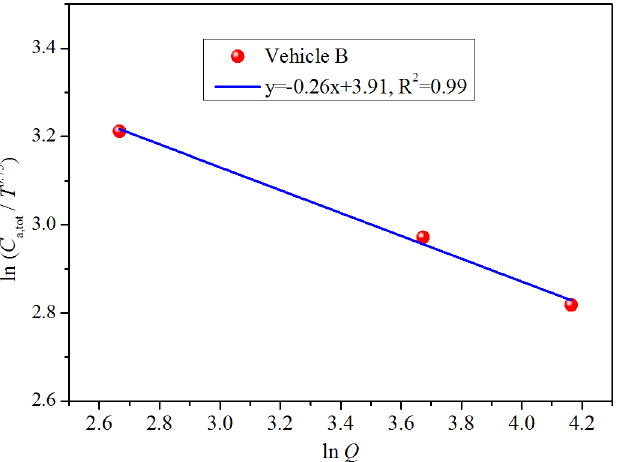
Fig 10. Validation of the correlation (20) with You et al. ’ s [28] experimental data from vehicular environments.